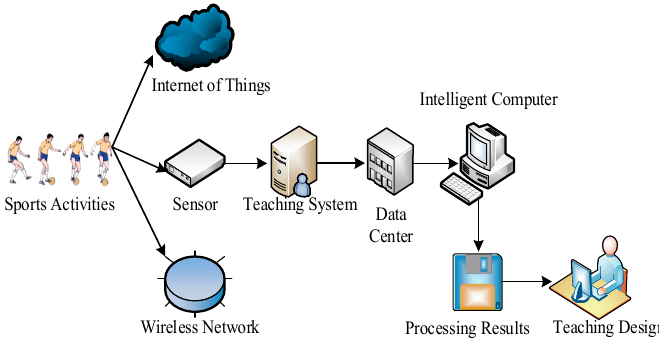
Figure 1. Overall architecture of teaching system.